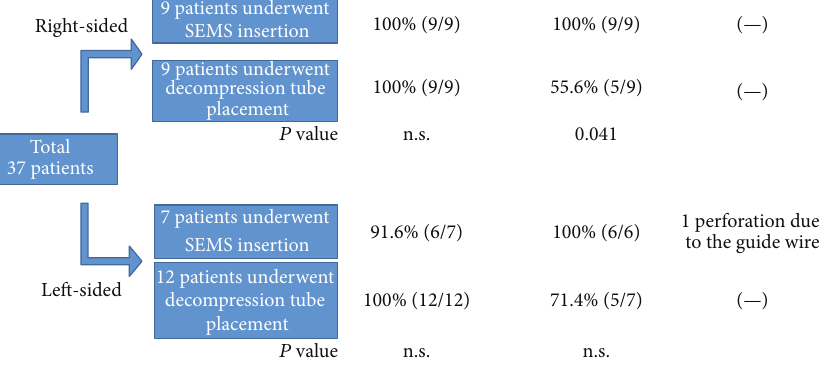
Figure 1: Overall results of this study.